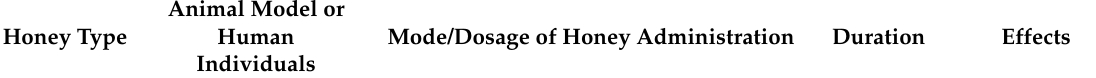
Table 6. In vivo studies of different monofloral honey